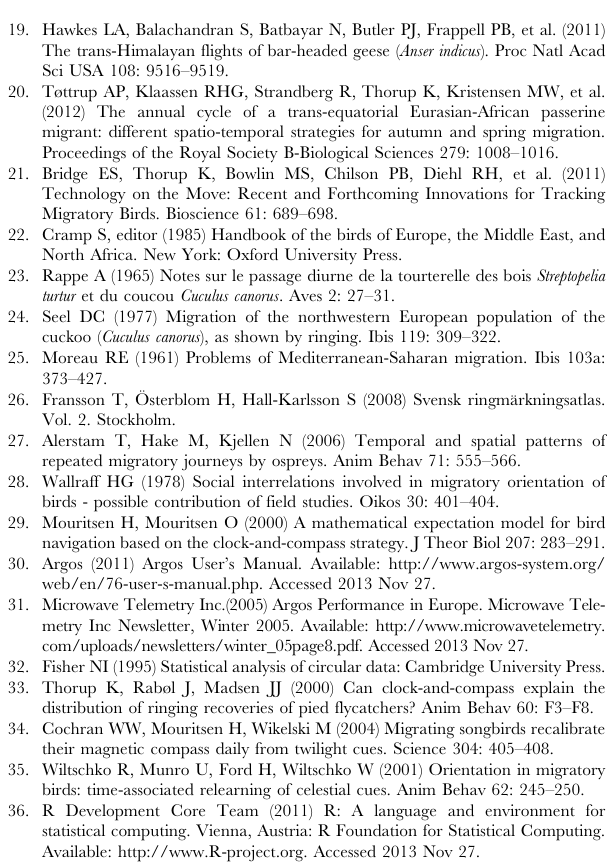
Figure S1 Tracks of eight individual common cuckoos as recorded by satellite telemetry. For stationary birds, only the highest quality position from each 10 h transmission period was included. For travelling birds, all positions during the 10 h transmission periods were used for analyses (cf. Methods). Figure S2 Timing of arrival of Common cuckoos in Denmark in 2011. The phenology of new unique locations with observations of cuckoos in Denmark in 2011. Note the main peak of new locations (indicating massive arrival) is in mid May. Source: DOFbasen, www.dofbasen.dk, Dansk Ornitologisk Forening (BirdLife Denmark). Accessed 2013 Nov 27. Table S1 Timing of migration stages in eight adult common cuckoos tracked by satellite telemetry. When departure or arrival was in a period of missing transmissions, the dates are not known exactly as indicated with ‘‘ , ’’ or ‘‘ . ’’. The symbol ‘‘-’’ indicates that a bird stopped transmitting before that stopover, whereas ‘‘?’’ indicates that we have no positions for the bird at that stopover, but it could have used it during a period with missing transmissions. Step distance and step direction are the basis for the actual vectors in the first simulations, and are the